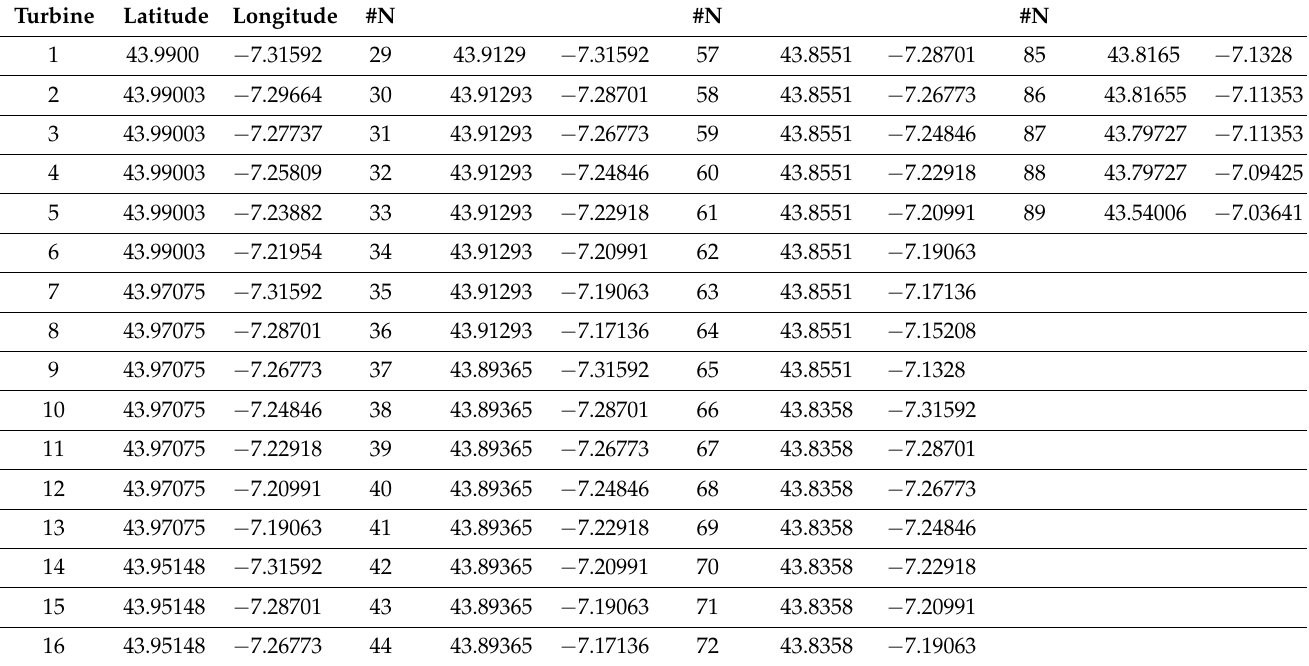
Table A1. Location of the turbines